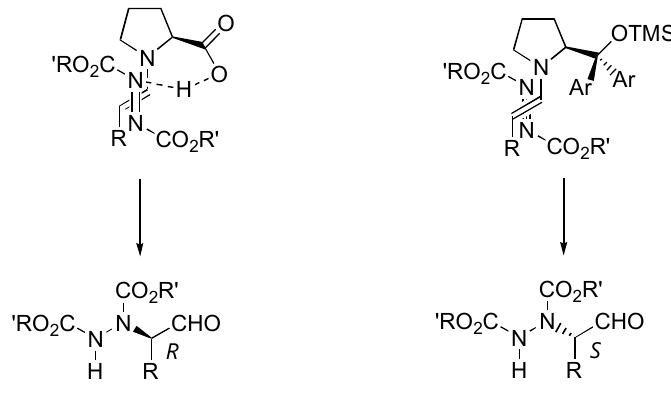
Figure 5. Models to explain the opposite enantioselectivity of amination of aldehydes catalyzed by 1 and 7